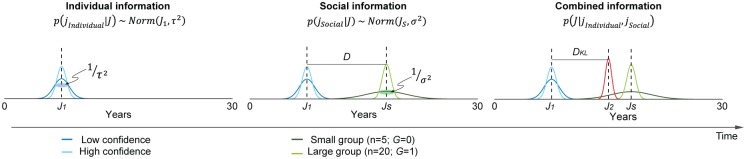
The Bayesian model predicting the changes in judgments under social influence.Individuals form a private estimate of the most preferable level of punishment for a criminal and make their initial judgments (J1). When the judgments of other social group members (JS) are observed, participants assigned weights to individual (J1; left panel) and social information (JS; middle panel) according to their respective credibility. These 2 beliefs are integrated into the final estimate (J2; right panel). Judgments are adjusted according to this final estimate. Changes in judgments from J1 to J2 were predicted by the belief updates, estimated by Kullback–Leibler divergence (DKL).